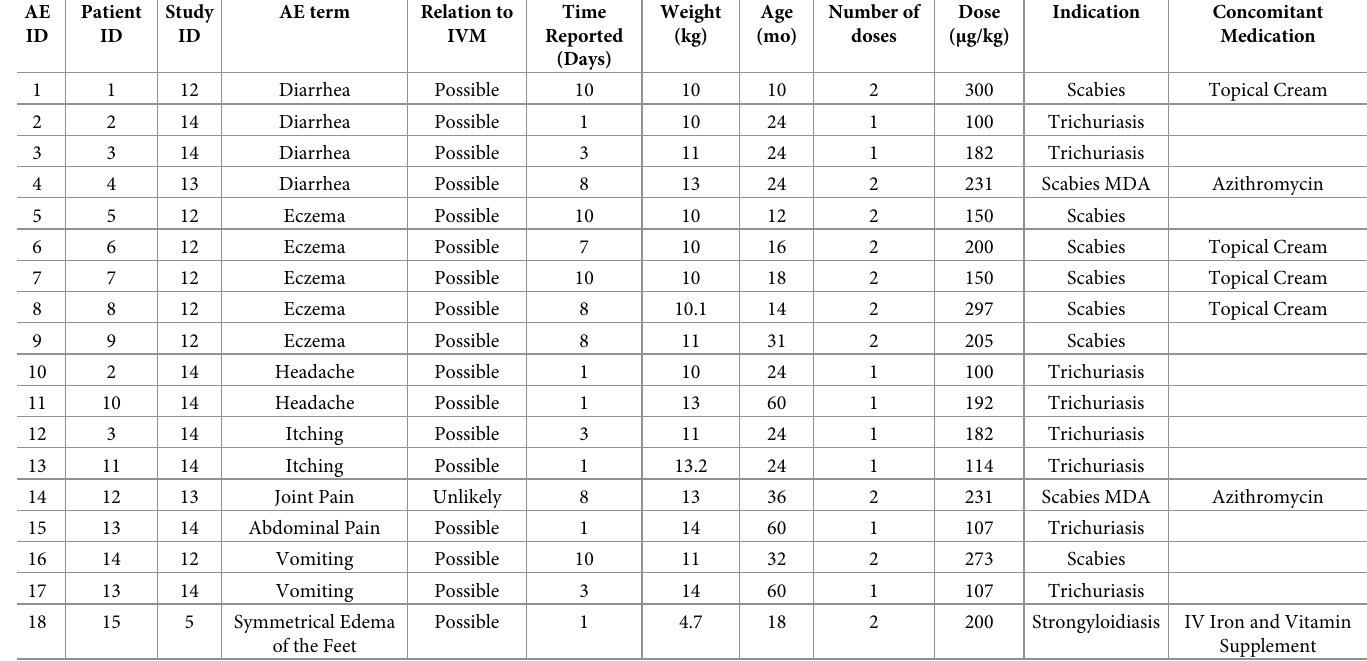
Table 2. Listing of individual adverse events (n = 18) following ivermectin ingestion. None of the AEs were classified as serious adverse